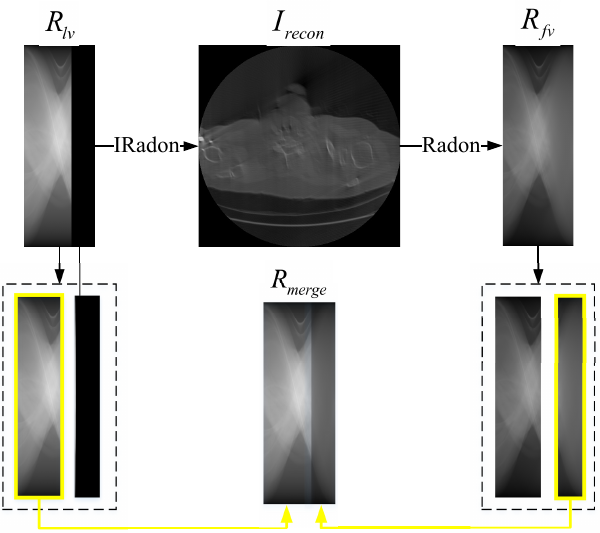
Figure 2. Workflow of data